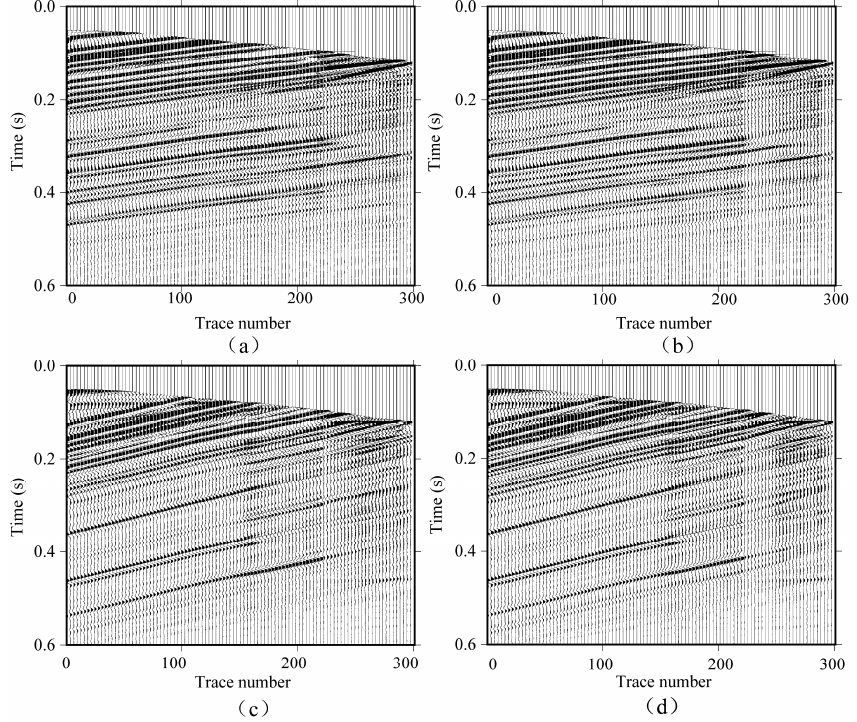
Figure 6. ( a , b ) The P waves separated from the upgoing waves in the corresponding vertical component of time-lapse cross-well shot gathers with the shallow source position (400 m) from the baseline survey and first-repeat survey, respectively. ( c , d ) as in ( a , b ) but displaying the PS waves separated from upgoing waves in the horizontal components instead.